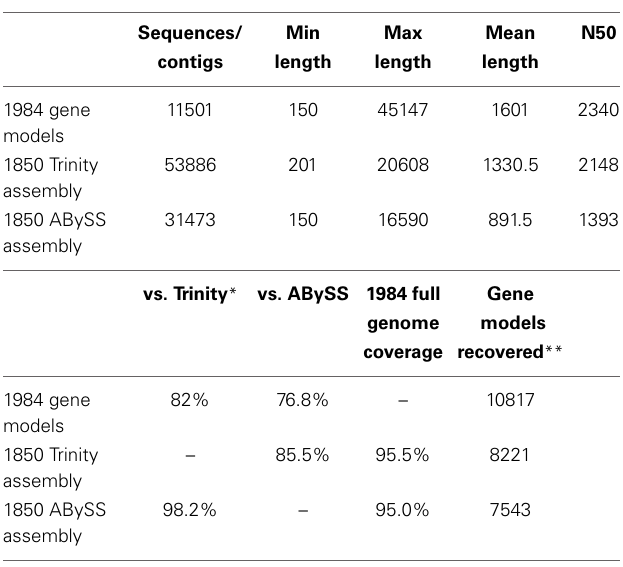
Table 3 | Trinity and ABySS de novo assembly statistics and comparisons between the CCMP 1984 gene model sequences and the assembled contigs from CCMP